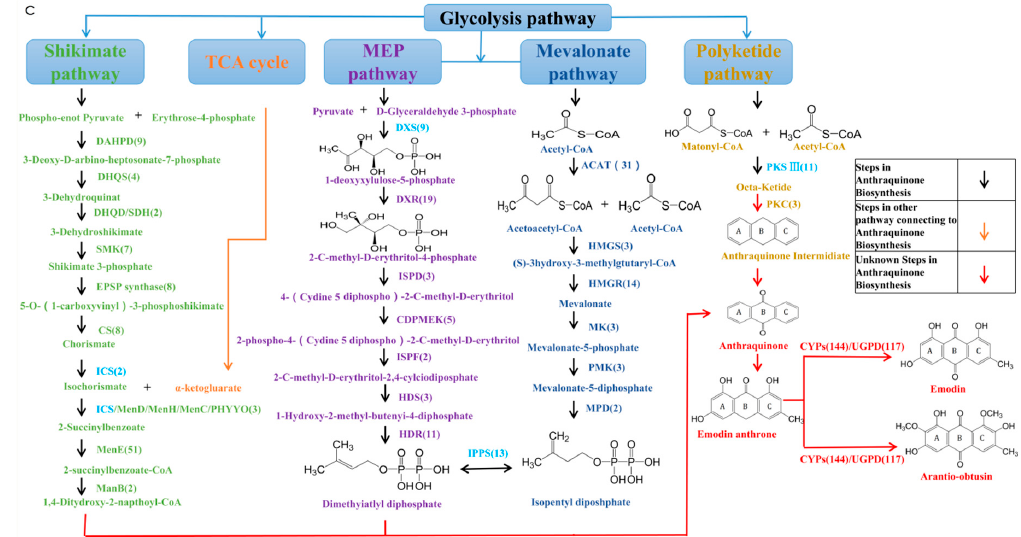
Figure 5. Various organs, aurantio ‐ obtusin biosynthesis ‐ related genes, and phytochemical analysis of C. obtusifolia . ( A ) Five various organs of C. obtusifolia. ( B ) Aurantio ‐ obtusin levels in the five various